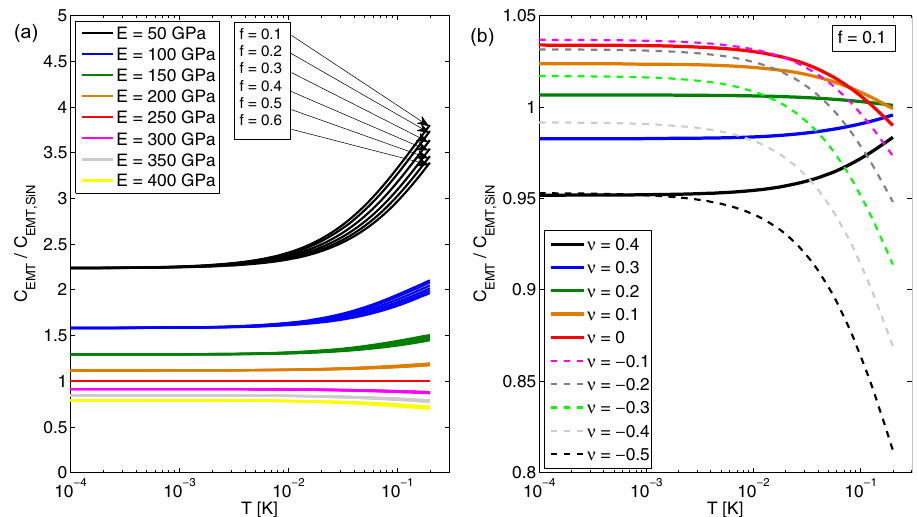
Fig. 7 Effect of the materials parameters on the EMT hear capacity. The heat capacity of a 50 nm thick PnC EMT metasolid for various Young ’ s moduli ( a ) and Poisson ratios ( b ), compared to the EMT result of the same PnC structure with SiN parameters ( E = 250 GPa, ρ = 3100 kg/m 3 , ν =